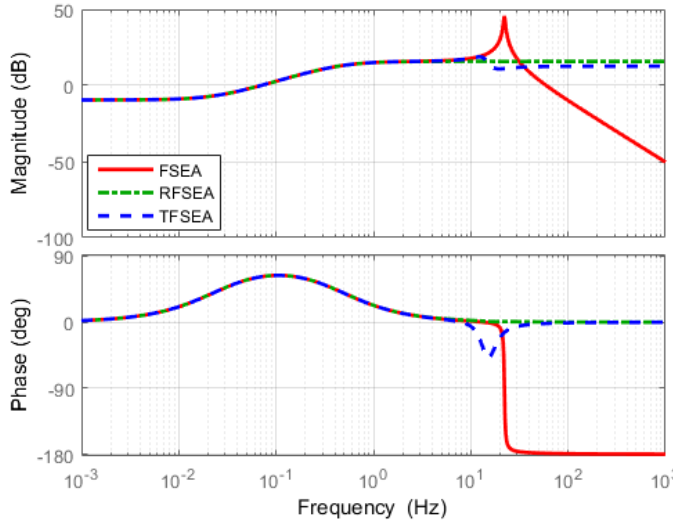
Figure 21. Frequency Response Functions (FRFs) of